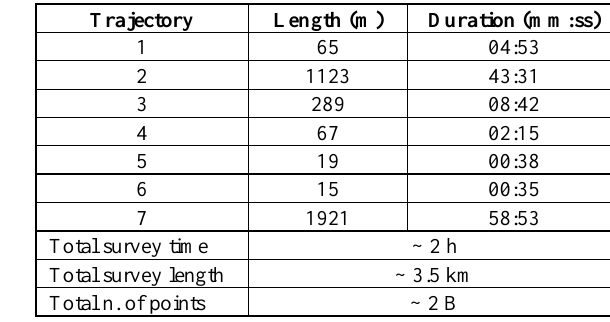
Table 1. Characteristics of the 7 trajectories acquired with Gexcel Heron MS Twin Color.